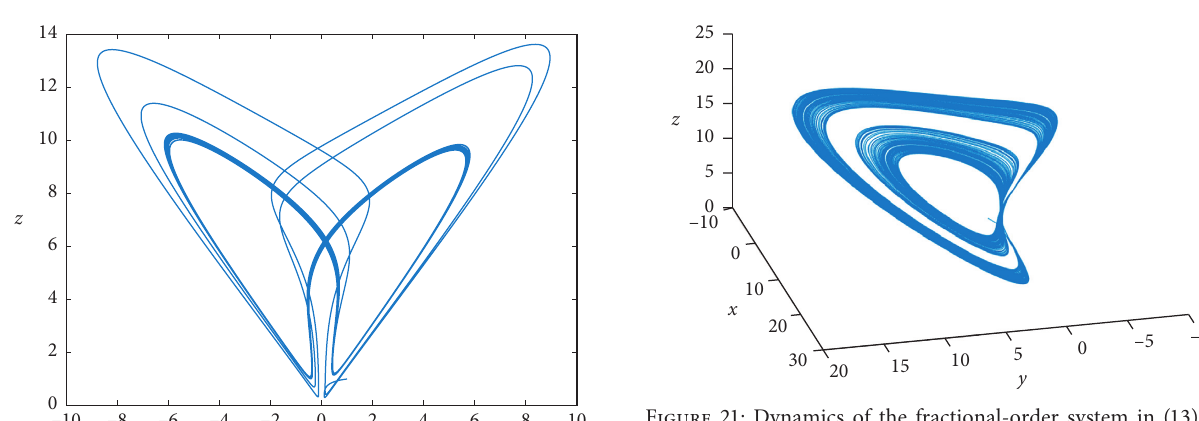
Figure 21: Dynamics of the fractional-order system in (13)–(15) with the order α � 0 . 92, in context of x , y , and z directions.